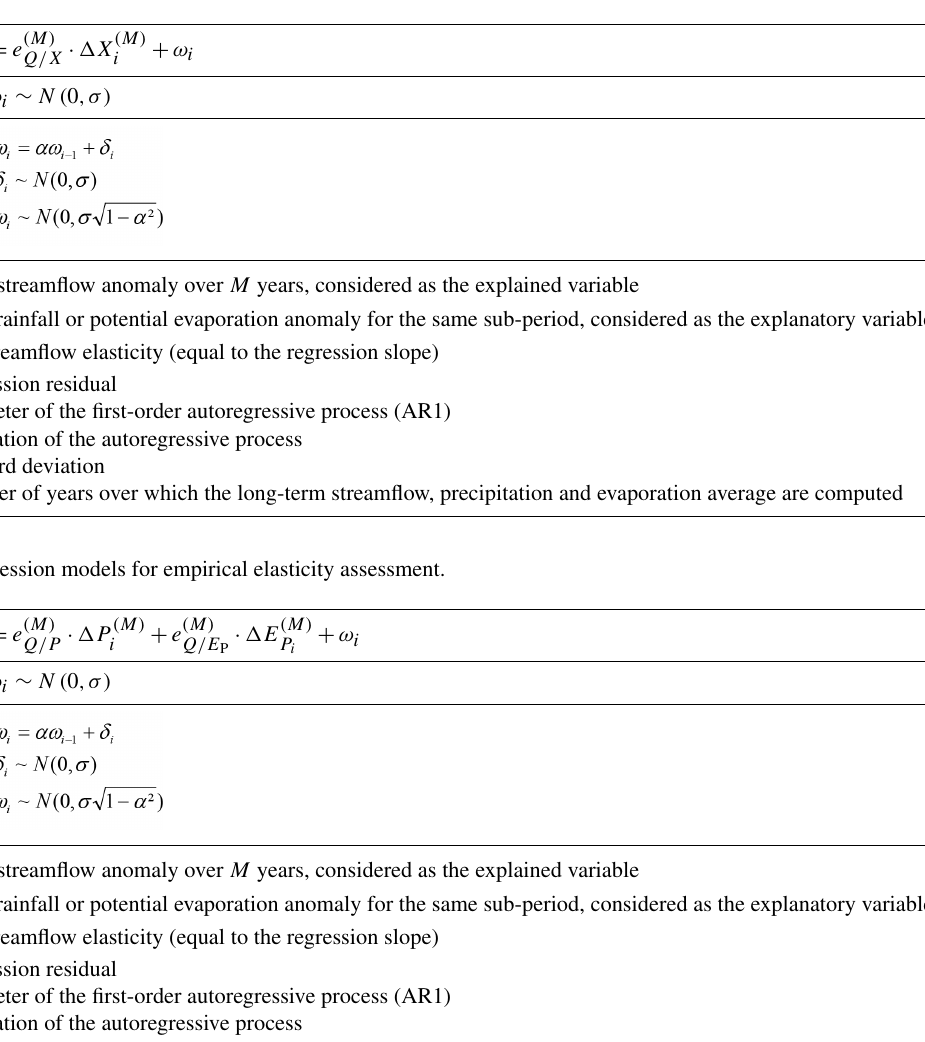
Table 4. Univariate regression models for empirical elasticity assessment.